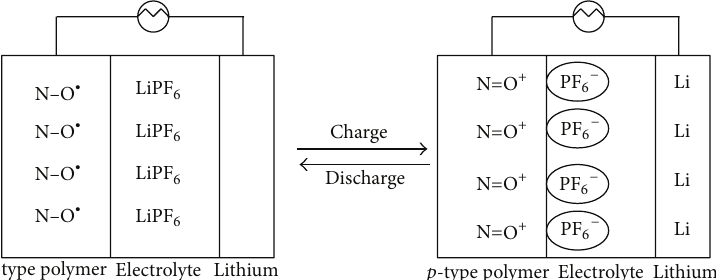
Figure 3: The charge/discharge mechanism of the organic radical Li-ion